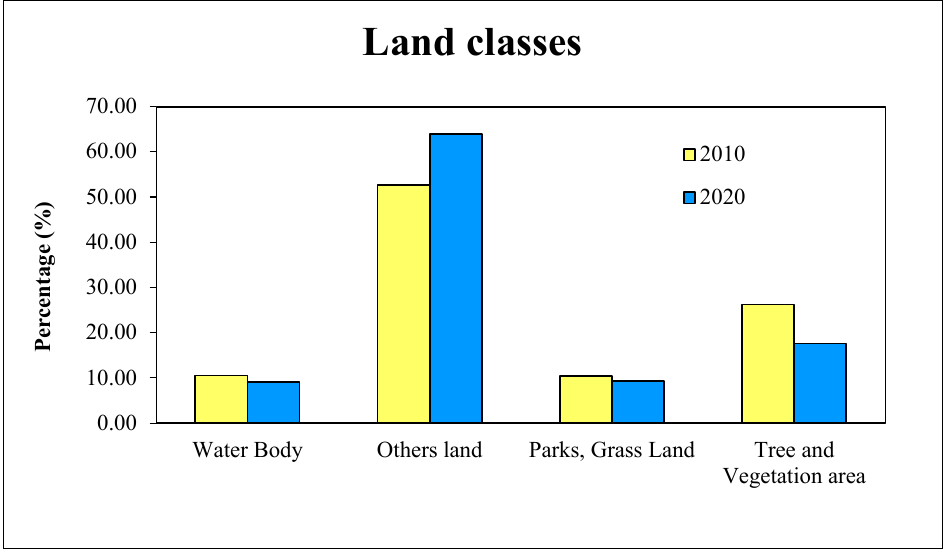
Figure 6. LULC change analysis using a bar diagram for 2010 and 2020 concerning West Bengal (Kolkata and Howrah).